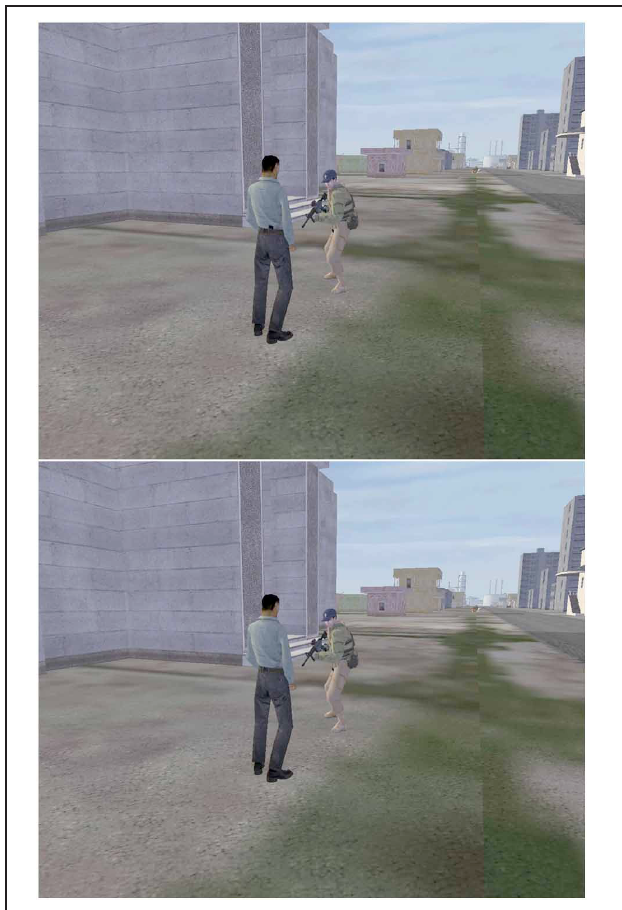
FIGURE 5 | Examples of images indicating threat (top) and non-threat (bottom) situations. From Falcone et al. (2012).